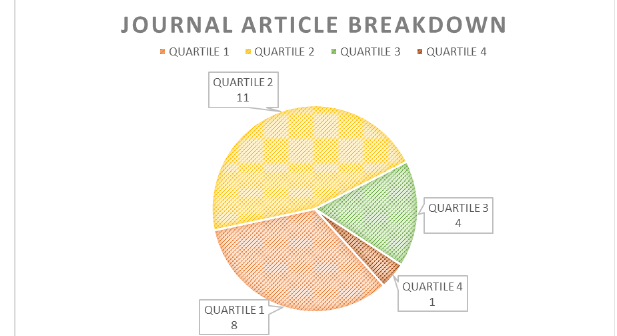
Figure 2 . An Overview of Journal Article Breakdown